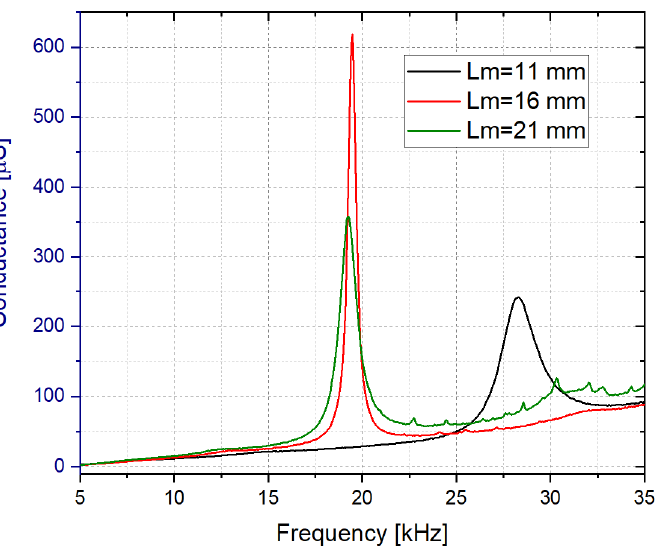
Figure 8. Conductance spectrum in water for the Rigid 10K resin based liquid cell with Lm = 11, 16 and 21 mm (Wm = 5 mm and Tm = 0.5 mm).